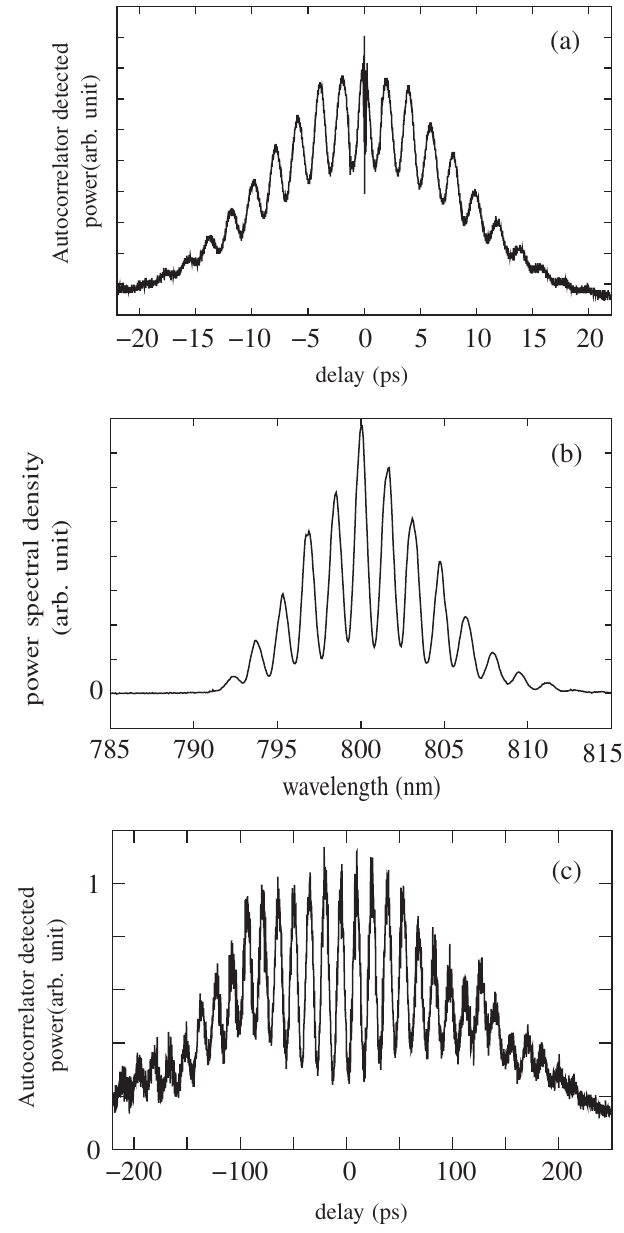
FIG. 4. Typical autocorrelation trace (a) and spectrum (b) of the relatively short pulses (in the 10 ps range) obtained with the previous setup, which used an external pulse stretcher. (c) Autocorrelation of long pulses ( (cid:2) 300 ps FWHM) using the actual pulse shaper.